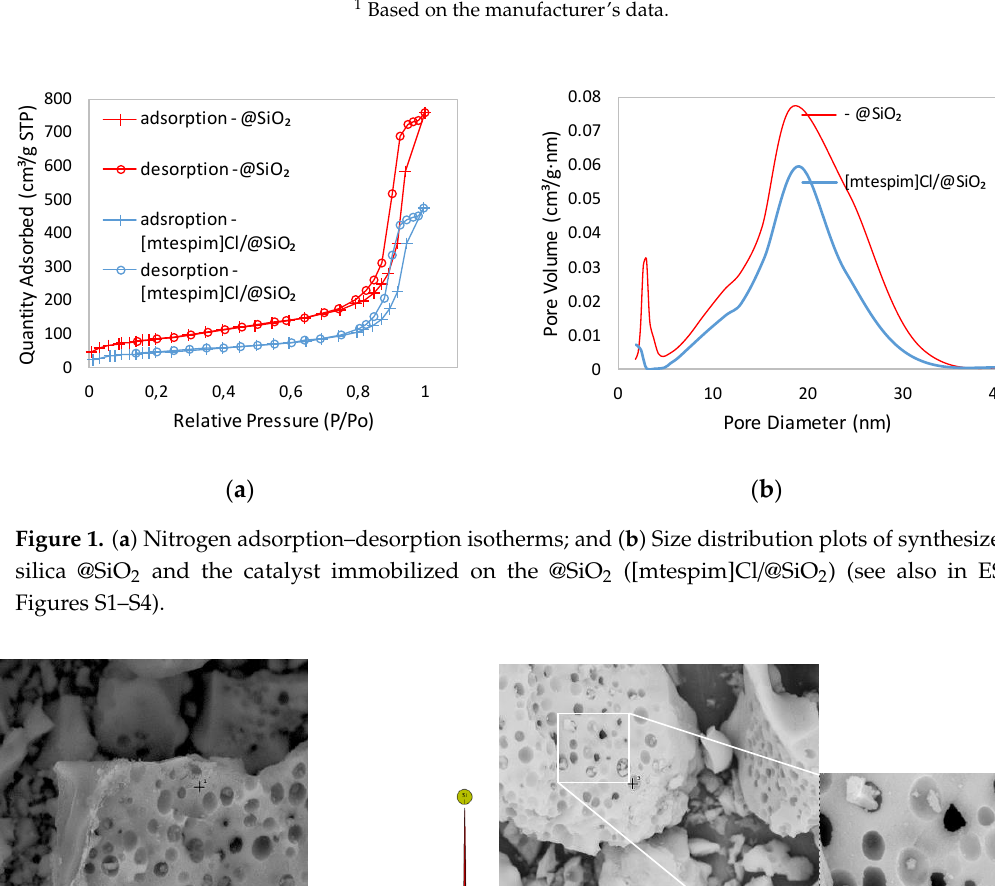
Figure 2. SEM images of: ( a ) @SiO 2 ; ( b ) Functionalized @SiO 2 sample ([mtespim]Cl/@SiO 2 ).